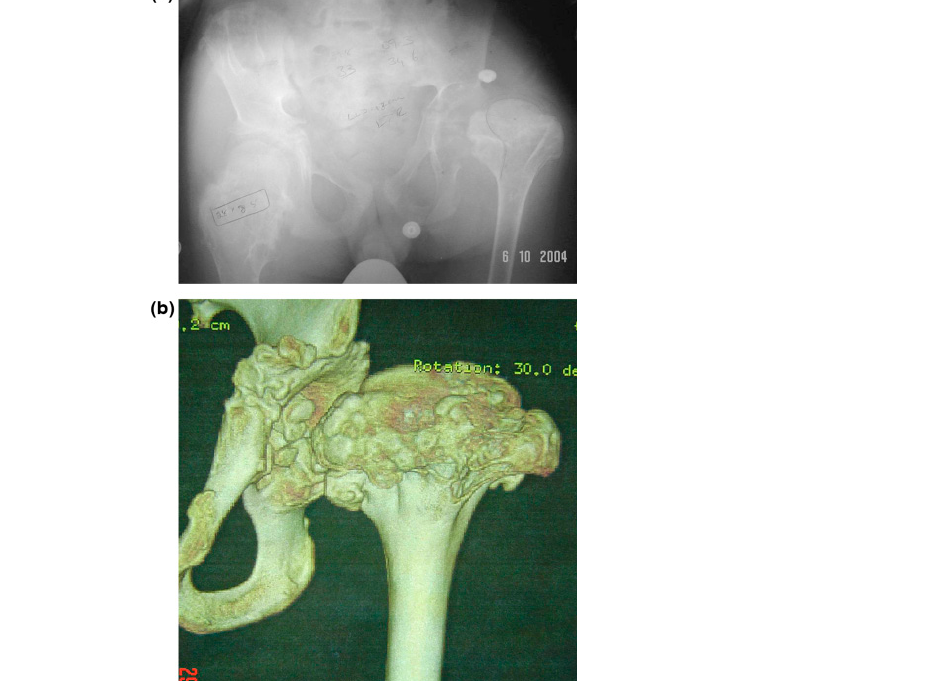
Figure 2. The images illustrate the case of a 14-year-old boy with Langer–Giedion syndrome (case no. 3). ( a ) Preoperative anteroposterior radiograph of the left hip shows osteochondromas at the femoral head and a completely dislocated hip. ( b ) Dislocated hip.